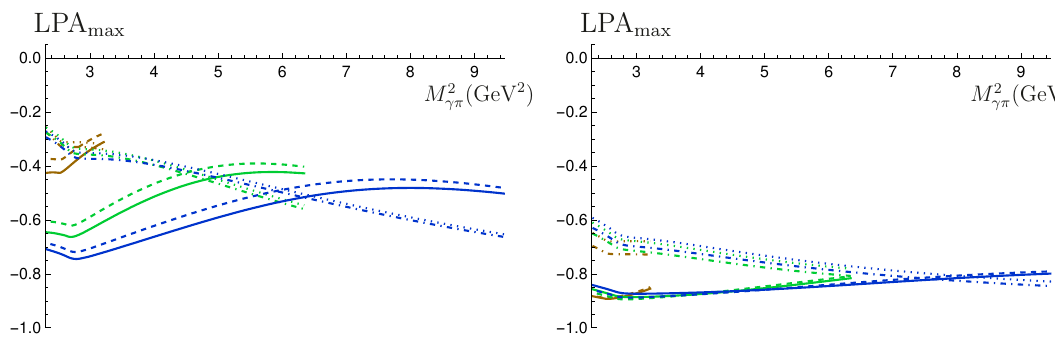
on γπ = 8 , 14 , 20 GeV 2 . The dashed γN